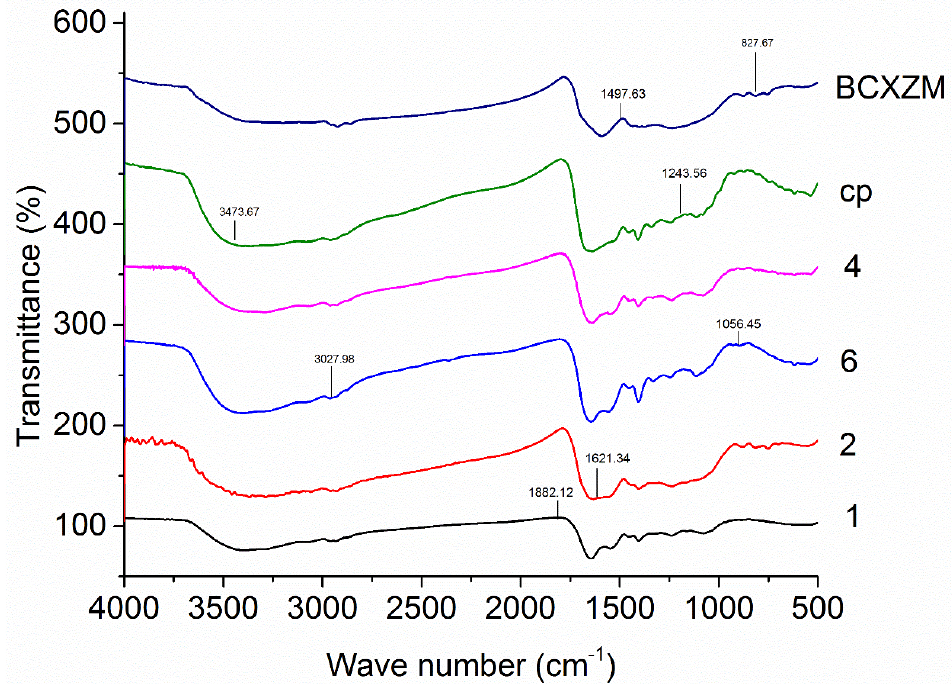
Figure 6. FTIR spectra of the native biochar and BCXZM composites after As(V) adsorption. Note: 1, 2, 4, 6 and cp correspond to the experimental conditions according to Table 1.